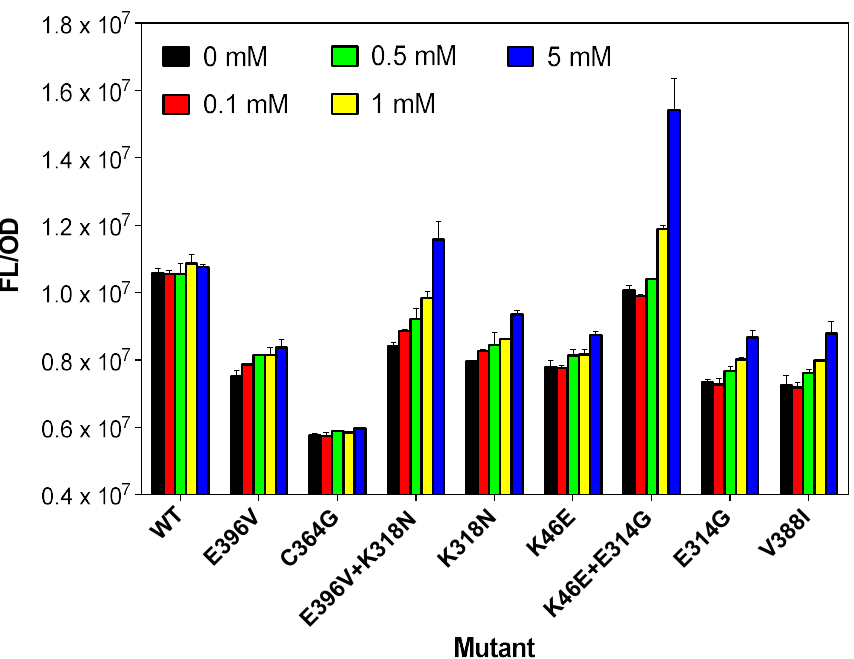
Figure 3. Fluorescence response of cells with pFrm-GESS and Lxmdh mutants to methanol. Cells harboring the formaldehyde biosensor plasmid pFrm-GESS and the Lxmdh variants were incubated with different concentrations of methanol in LB for 8 h.